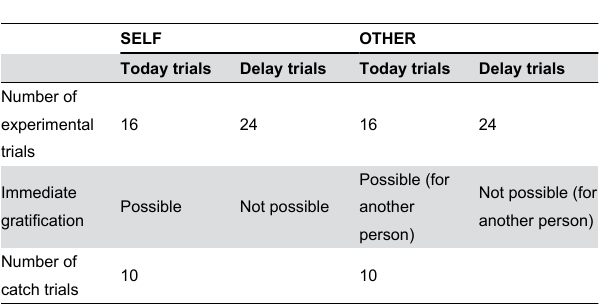
Table 1. Overview of